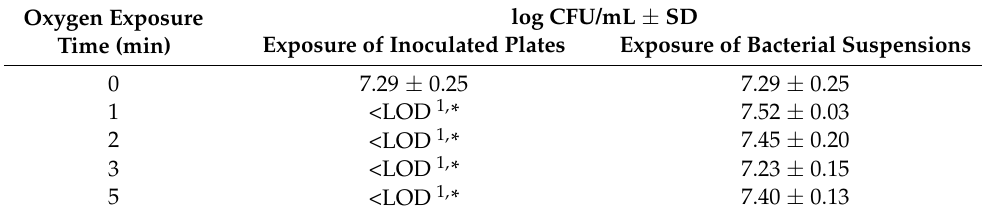
Table 1. Viability of F. duncaniae DSM 17677 free cells when exposed to ambient air. Data represent the mean values of log CFU/mL ± standard deviation (SD) obtained in the exposure of inoculated plates and after plating of bacterial suspension within 15 mL centrifuge tubes exposed for different time